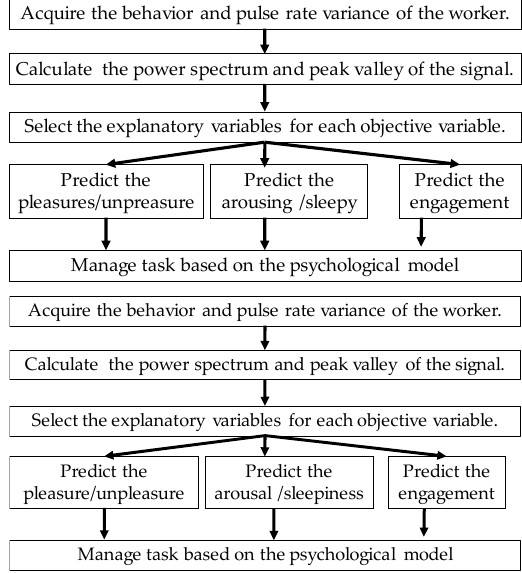
Figure 1. Task management using the prediction of pleasure, arousal, and engagement.